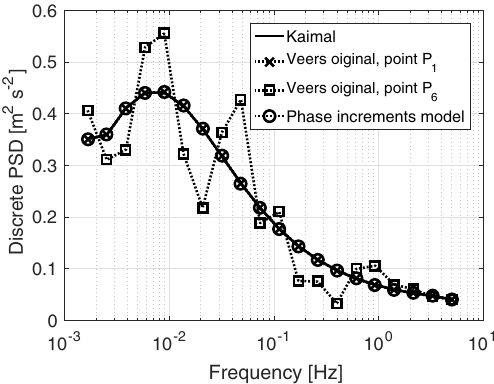
Figure 2. Raw wind spectra from a single wind speed sample; no averaging. Kaimal: the analytic spectrum; Veers: sample of the spectrum resulting from Eq. (3) at two different points P 1 and P 6 ; phase increments: the spectrum from the reduced-order phase in- crement model Eq. (8) (identical for all points). The values from Kaimal, Veers’ original ( P 1 ), and the phase increment models all collapse to the same